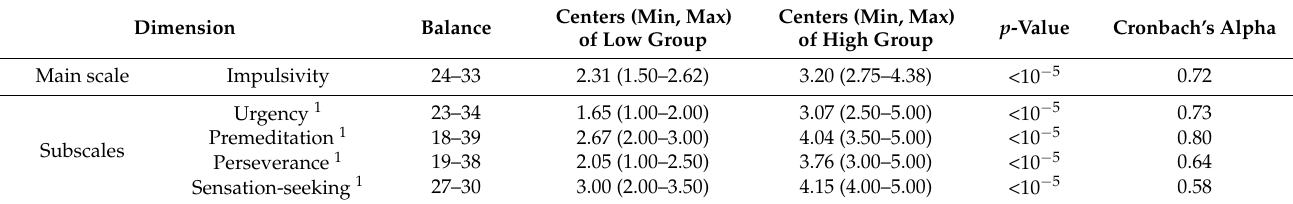
Table 2. Extracting the labels based on the